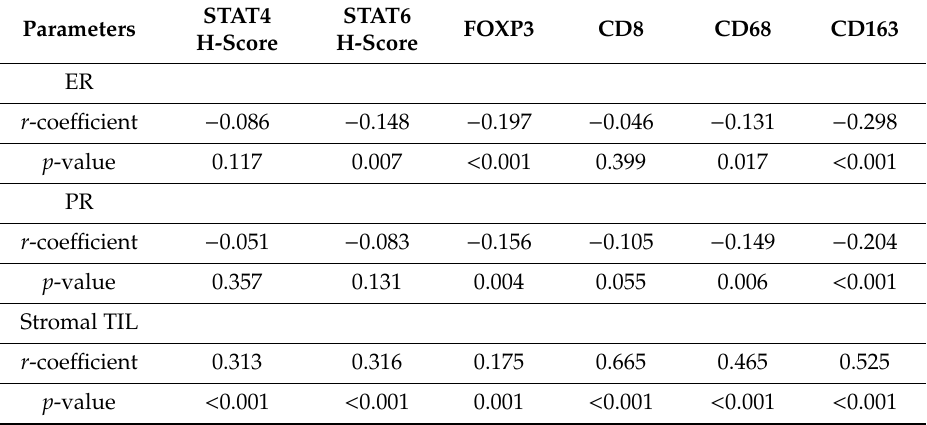
Table 4. Correlations between the proportions (%) of ER, PR, and stromal TIL expression levels and immune cell subtype-related protein expression